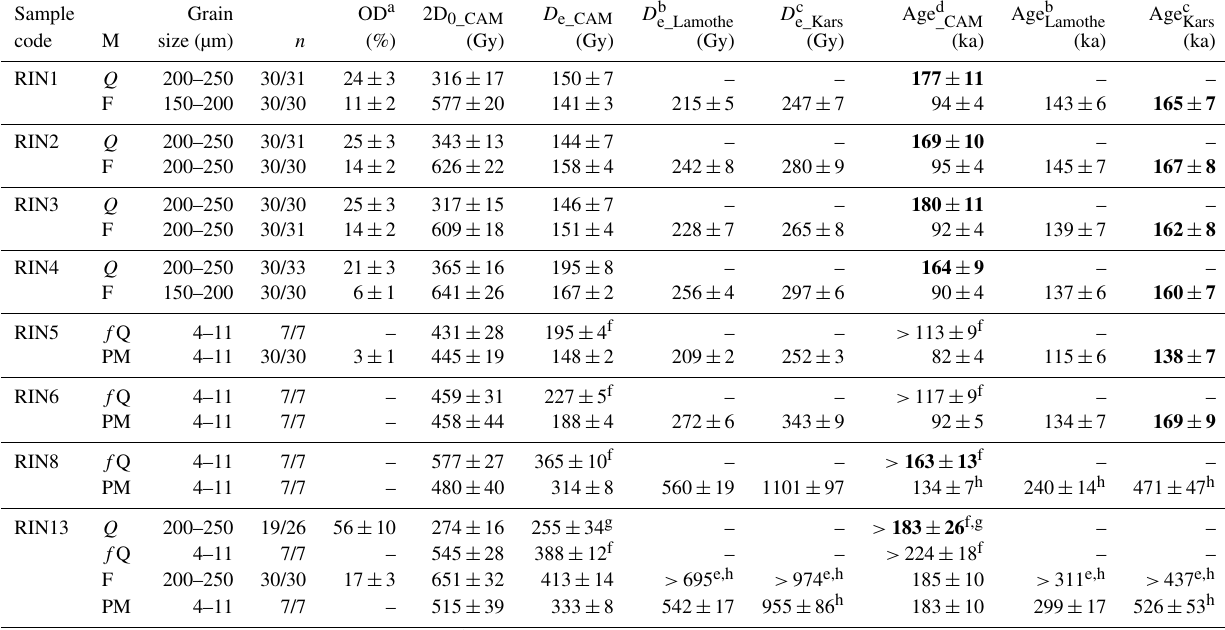
Table 1. D e values and derived ages for all samples; 1 σ uncertainties are given. Presented values are obtained using the central age model (CAM, Galbraith et al., 1999). The number of accepted and measured aliquots is provided by n . The measured mineral, i.e. coarse-grained quartz (Q), fine-grained quartz (fQ), feldspar (F), and polymineral (PM), is given by M. Ages to be considered for chrono-stratigraphic interpretation are presented in